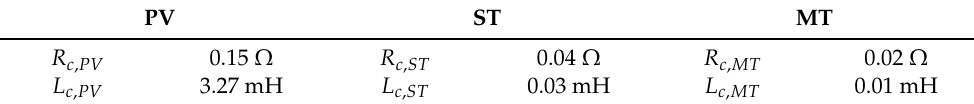
Table 3. Grid parameters.